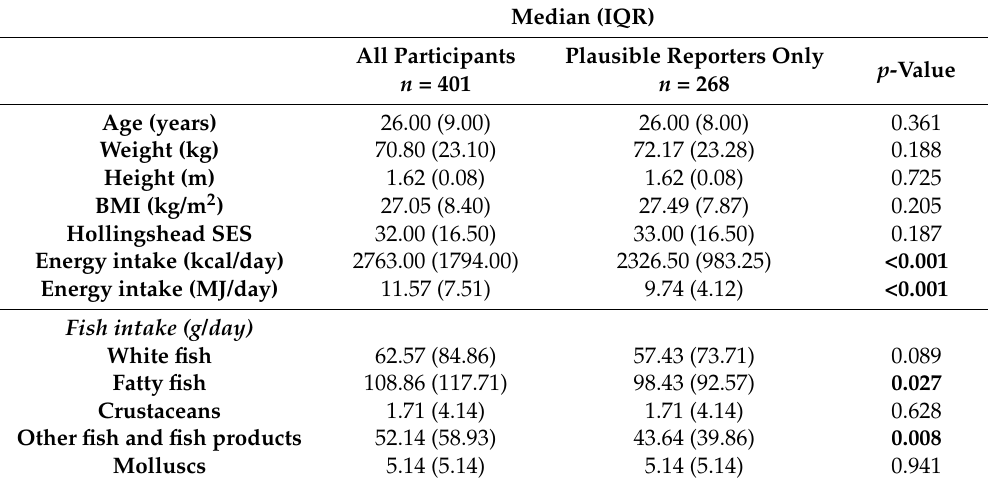
Table 2. Characteristics of all participants and plausible reporters